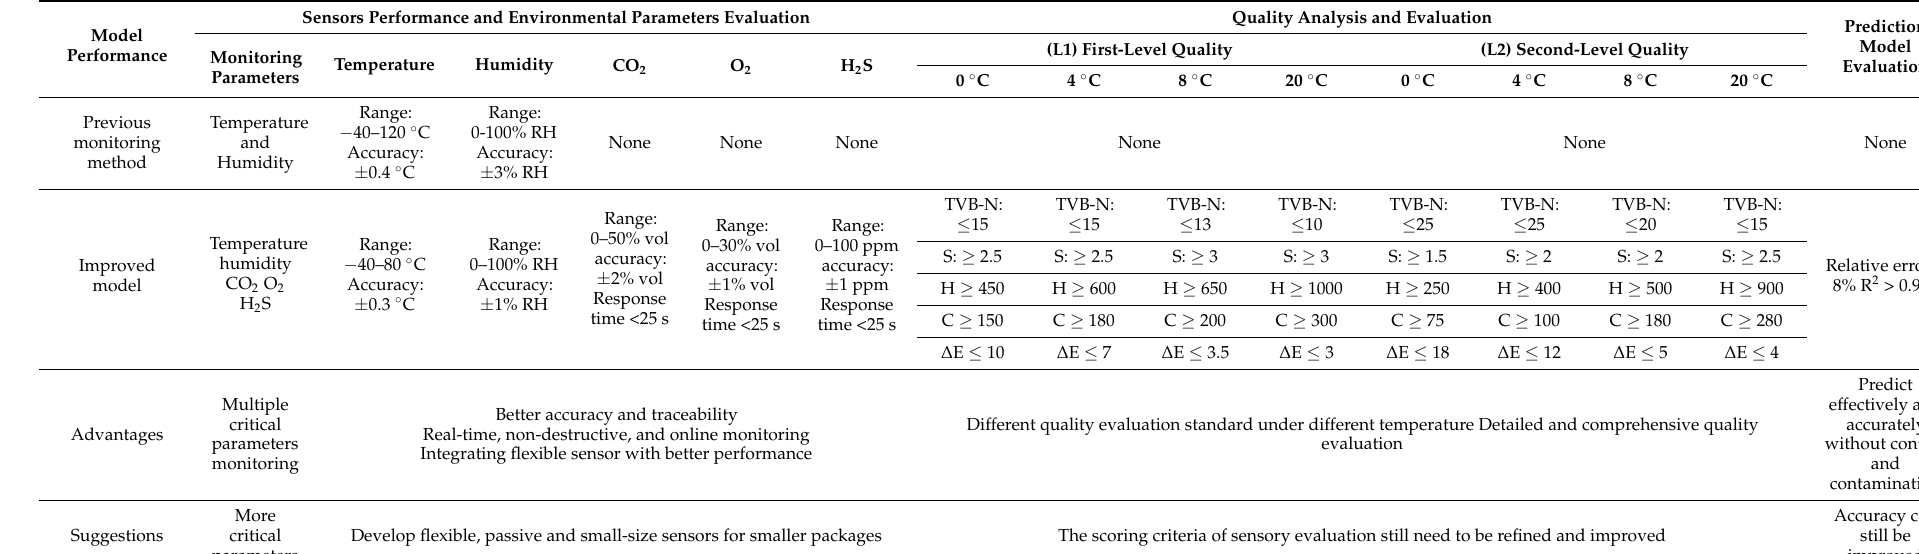
Table 4. Comprehensive comparison of the traditional model and proposed